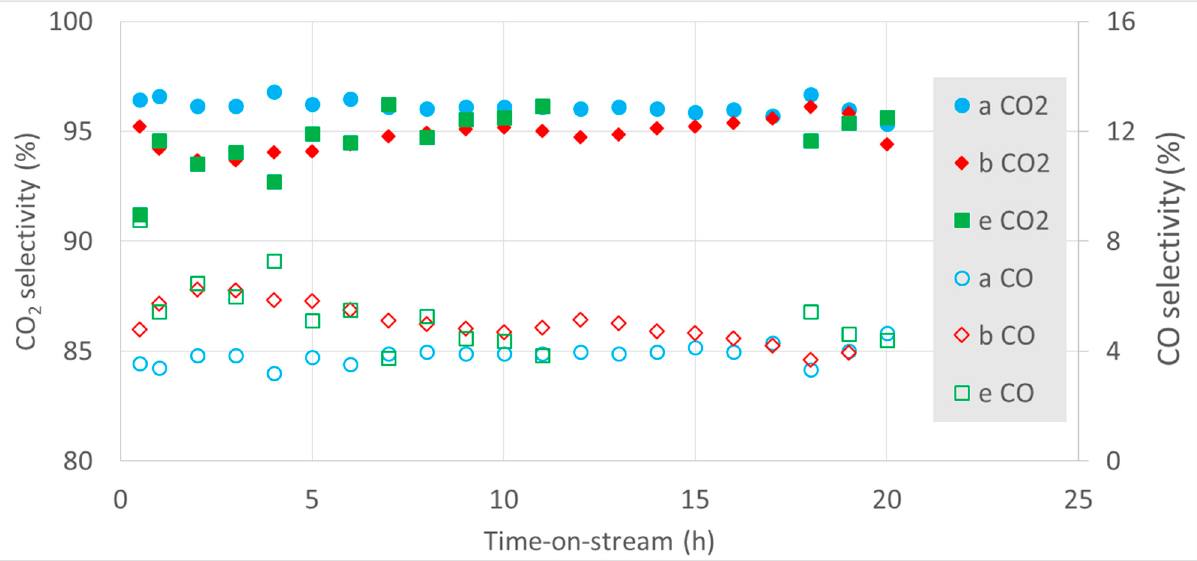
Figure 9. Selectivity to CO (right) and CO 2 (left) at 650 °C, feed 10 wt% glycerol in water. ( a ) La 0.3 Zr 0.7 NiO 3 ; ( b ) 10 wt% Ni/(0.3La 2 O 3 –0.7ZrO 2 ); ( e ) La 0.3 Ce 0.7 NiO 3 .